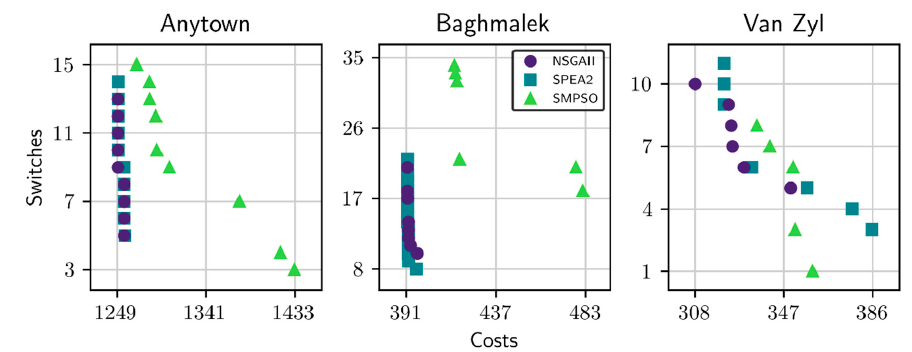
Figure 5. Approximations to the Pareto front obtained by the NSGA-II, SPEA2, and SMPSO algorithms for the (left) Anytown, (center) Baghmalek, and (right) Van Zyl network case studies.